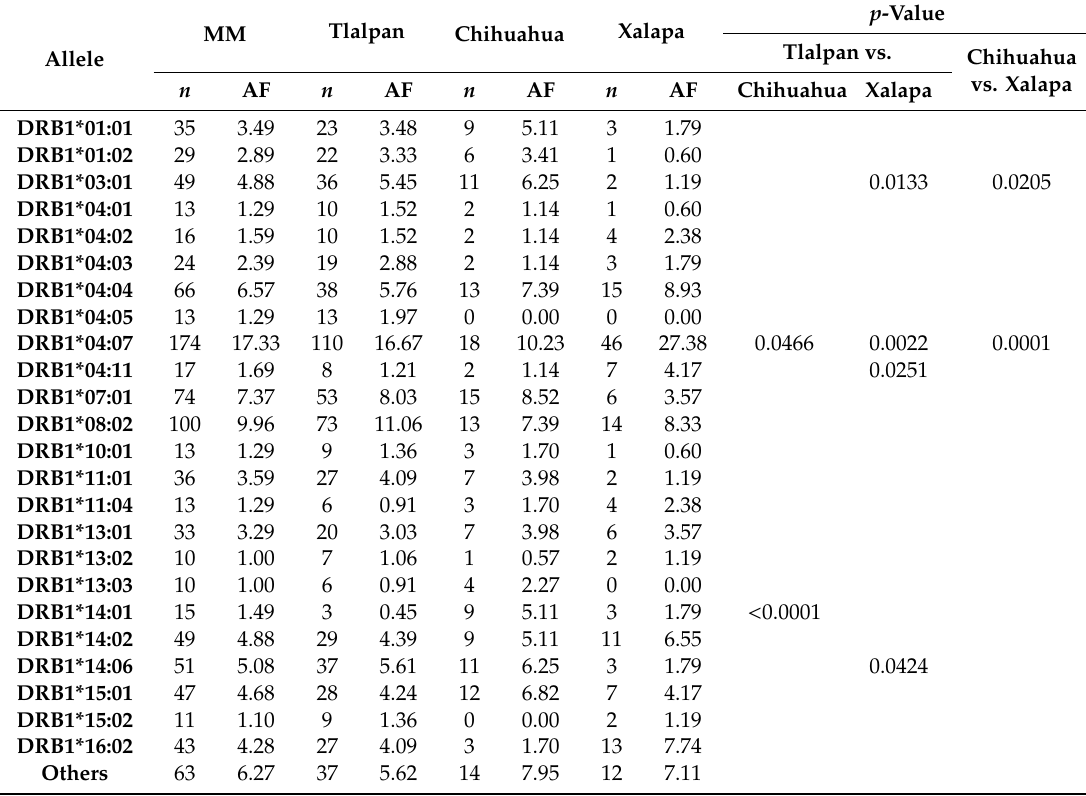
Table 4. HLA-DRB1 allele frequency from Mexico: Tlalpan, Chihuahua, and Xalapa.